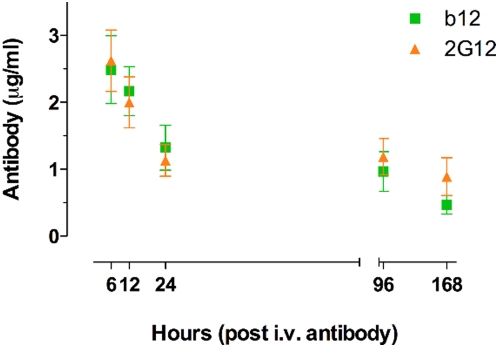
Comparison of b12 and 2G12 transudated to the vagina following intravenous administration.Each antibody treatment group consisted of three female Indian Rhesus macaques which were i.v.-administered 5 mg/kg of either b12 or 2G12 following Depo-provera treatment. Vaginal secretions from each animal were absorbed to cellulose wicks. A set of 3 samples per animal was taken at 6 hours, 12 hours, 24 hours, 4 days, and 7 days post i.v. antibody administration. The concentration of antibody in mucosal secretions was determined by ELISA from the clarified supernatant extracted from the wicks. Resulting data were compared to the corresponding antibody standard curve using nonlinear regression. Arithmetic means and standard deviations were calculated for each set of triplicate samples per animal. Data points were calculated from all animals at each timepoint and error bars represent the standard error of means. The typical time for viral challenge in protection experiments is indicated. The differences in the mean concentrations of b12 and 2G12 at each timepoint were evaluated in a student's t test and determined to be non-significant. Analyses performed in GraphPad Prism Software for Mac, Version 5.0a.